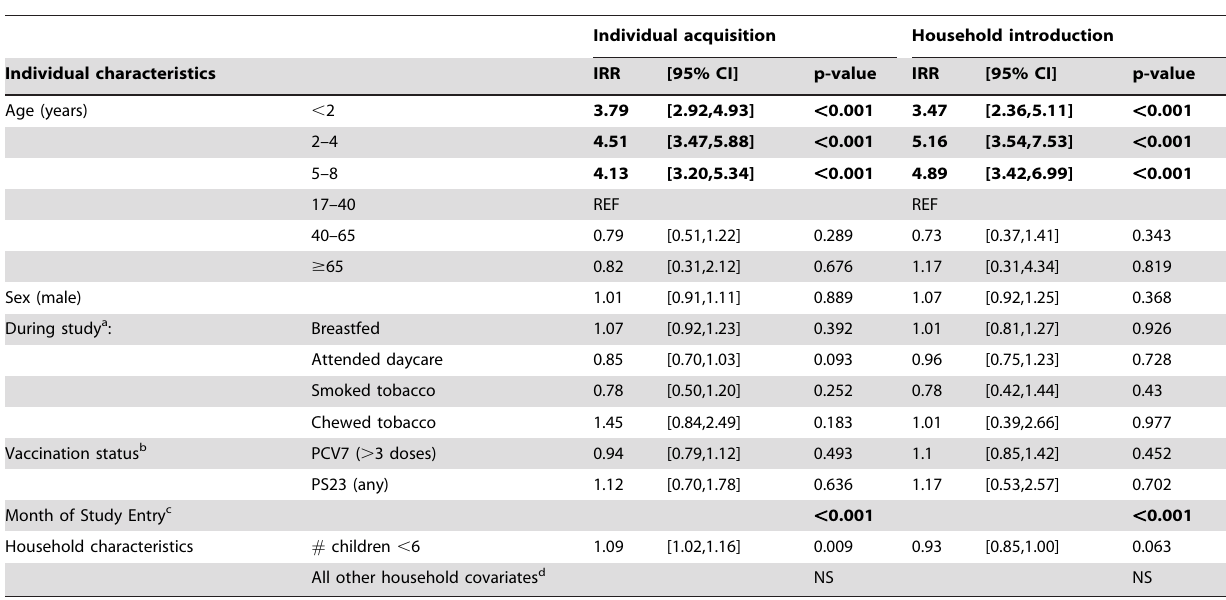
Table 3. Risk factors for pneumococcal acquisition (Poisson regression).